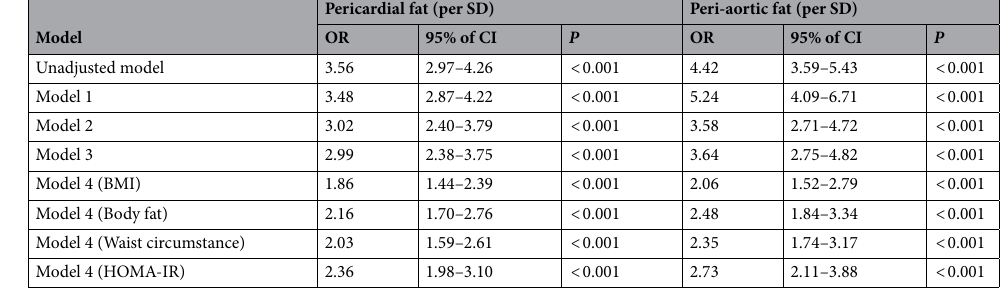
Table 3. The association of pericardial fat (PCF), thoracic peri-aortic adipose tissue (TAT) with fatty liver diagnosis in various adjustment models. Model 1 adjusted for age, gender; Model 2: adjusted for age, gender, SBP, fasting glucose, triglyceride, HDL, cholesterol, eGFR, hypertension, diabetes, hyperlipidemia; Model 3: adjusted for age, gender, SBP, fasting glucose, triglyceride, HDL, cholesterol, eGFR, hypertension, diabetes, hyperlipidemia, life style (regular exercise, alcohol consumption, and smoking); Model 4: further adjusted for BMI, body fat, HOMA-IR or waist circumstance, separately. PCF pericardial fat, TAT thoracic peri-aortic adipose tissue.